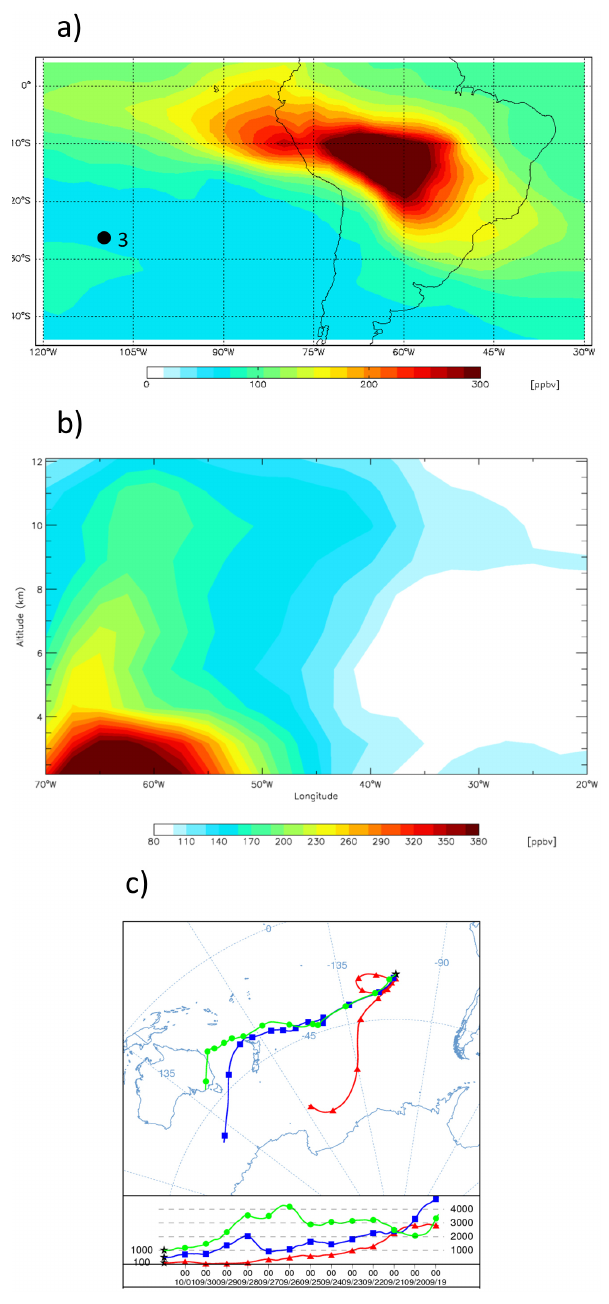
Figure 5. (a) Monthly averaged CO concentrations (ppb) predicted by GEOS-Chem model over South America at 704hPa in Septem- ber 2006. The station location (refer to Fig. 1 for station number) is also shown. (b) Vertical CO distribution at 14 ◦ S over burning areas of South America in September 2006. (c) A typical 13-day back- ward trajectory launched on 2 October 2002 from Easter